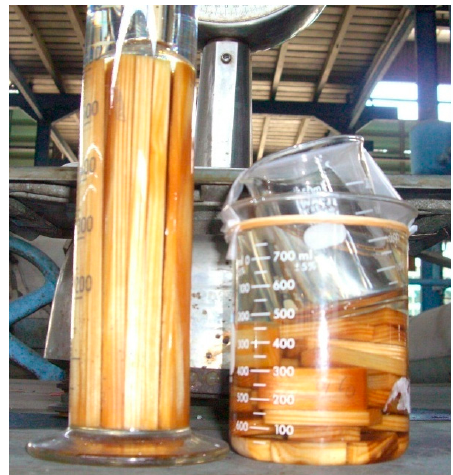
Figure 1. Styrene impregnation of the samples.